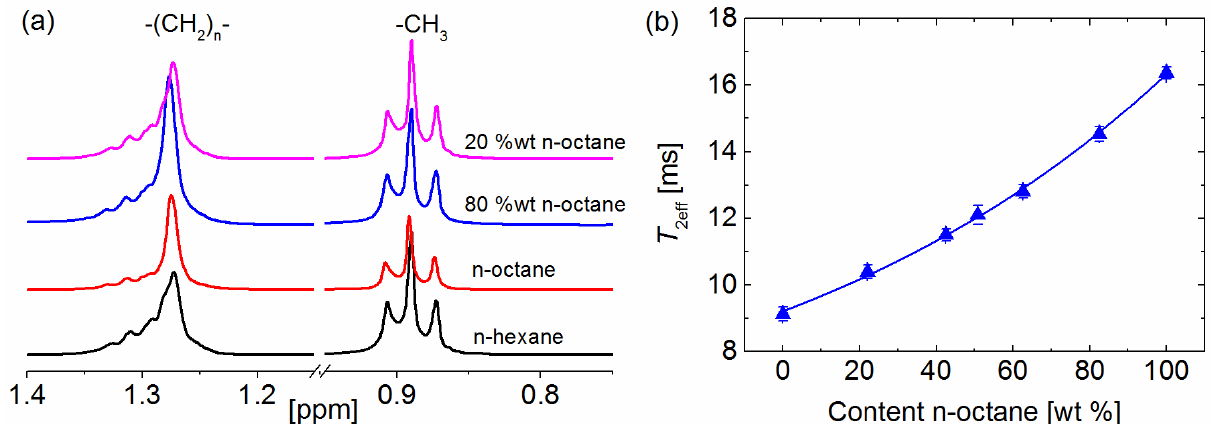
Figure 5. ( a ) Proton liquid-state spectra of pure n-octane, pure n-hexane, and two mixtures of them measured at room temperature. Both solvents show signals in the same range of chemical shifts. ( b ) Correlation of the low-field NMR relaxation times with the n-octane content in a binary mixture with n-hexane. The line depicts the fit result using the equation T 2eff_mixture = 5.03 × exp(content/113) + 4.17 with a correlation factor higher than 0.99.